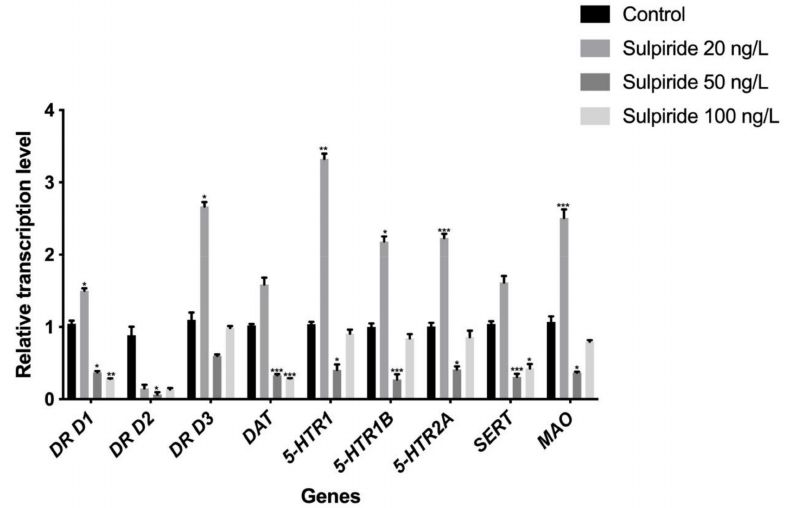
Figure 1. Sulpiride exposure for 14 days induced changes in gene transcription levels of functional molecules of DA and 5-HT neurotransmitter systems in octopus brain tissue. Note: * compared with the control group, p < 0.05; ** compared with the control group, p < 0.01; *** compared with the control group, p < 0.001; n =